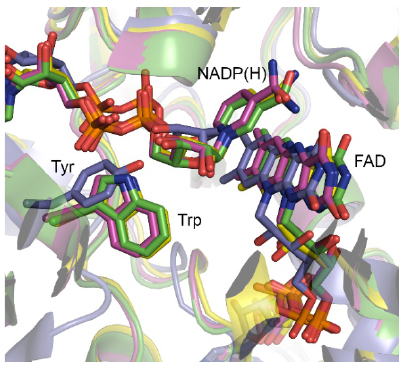
Figure 1. Structural comparison of selected BVMOs showing the active site with bound FAD and NADP(H), and corresponding residue to T513 of BVMO AFL210 . CHMO from Rhodococcus sp. HI-31 is shown in green (3GWD), PockeMO in blue (5MQ6), PAMO in yellow (2YLR) and CHMO from Thermocrispum municipale in pink (5M10). Catalysts 2020 , 10 , x FOR PEER REVIEW